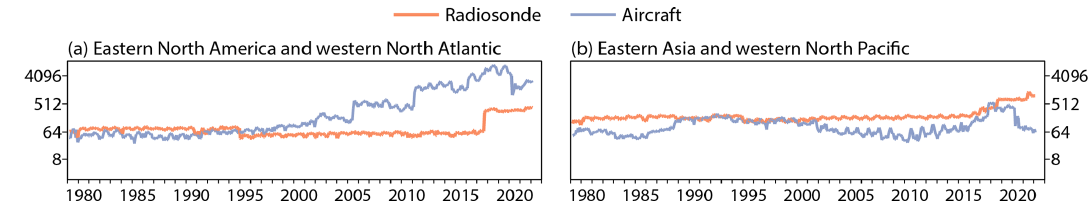
Figure 14. Monthly average number of observations per day for the 175 to 225hPa layer, from March 1979 to February 2022, for radiosondes (orange) over the regions (a) from 35 to 55 ◦ N and 80 to 50 ◦ W and (b) from 25 to 45 ◦ N and 115 to 145 ◦ E and for aircraft (blue) over the regions (a) from 35 to 55 ◦ N and 60 to 30 ◦ W and (b) from 25 to 45 ◦ N and 145 to 175 ◦